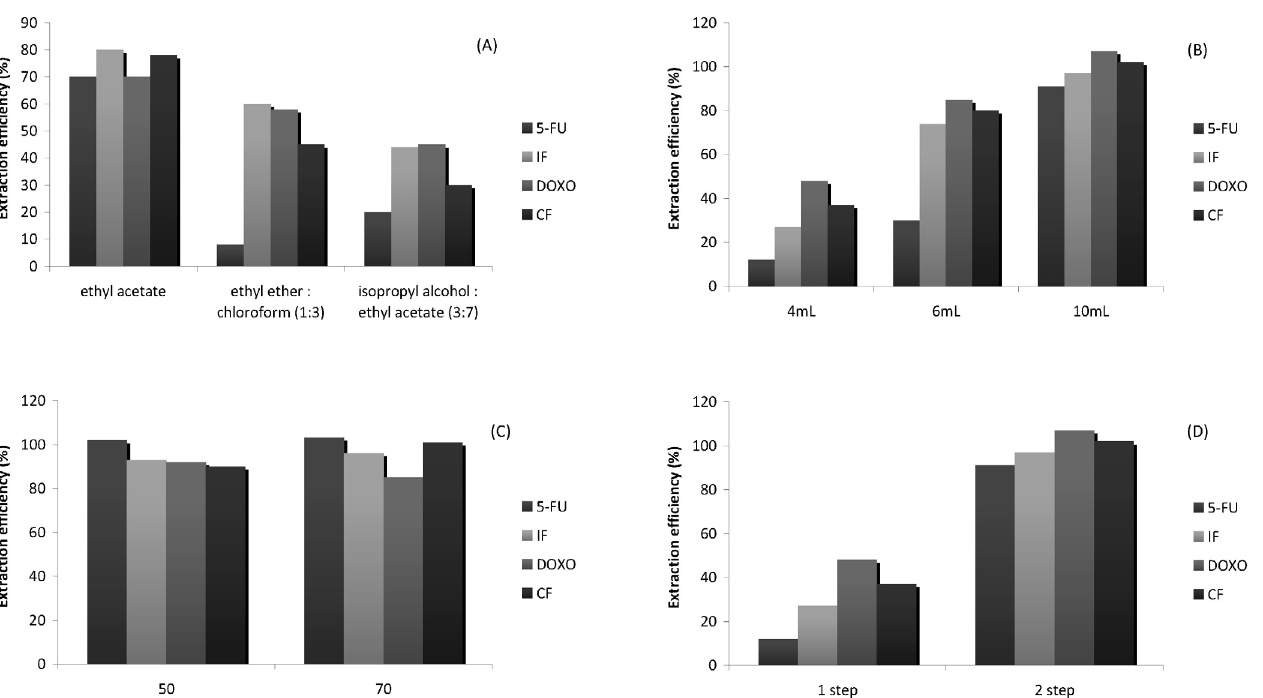
FIGURE 2 - Results expressed as extraction efficiency (%) of fluorouracil (5-FU), ifosfamide (IF), cyclophosphamide (CP) and doxorubicin (DOX), in the LLE studies of type (A) and solvent extractor volume (B), shaking velocity (C) and number of extractions totaling 10 mL (D).